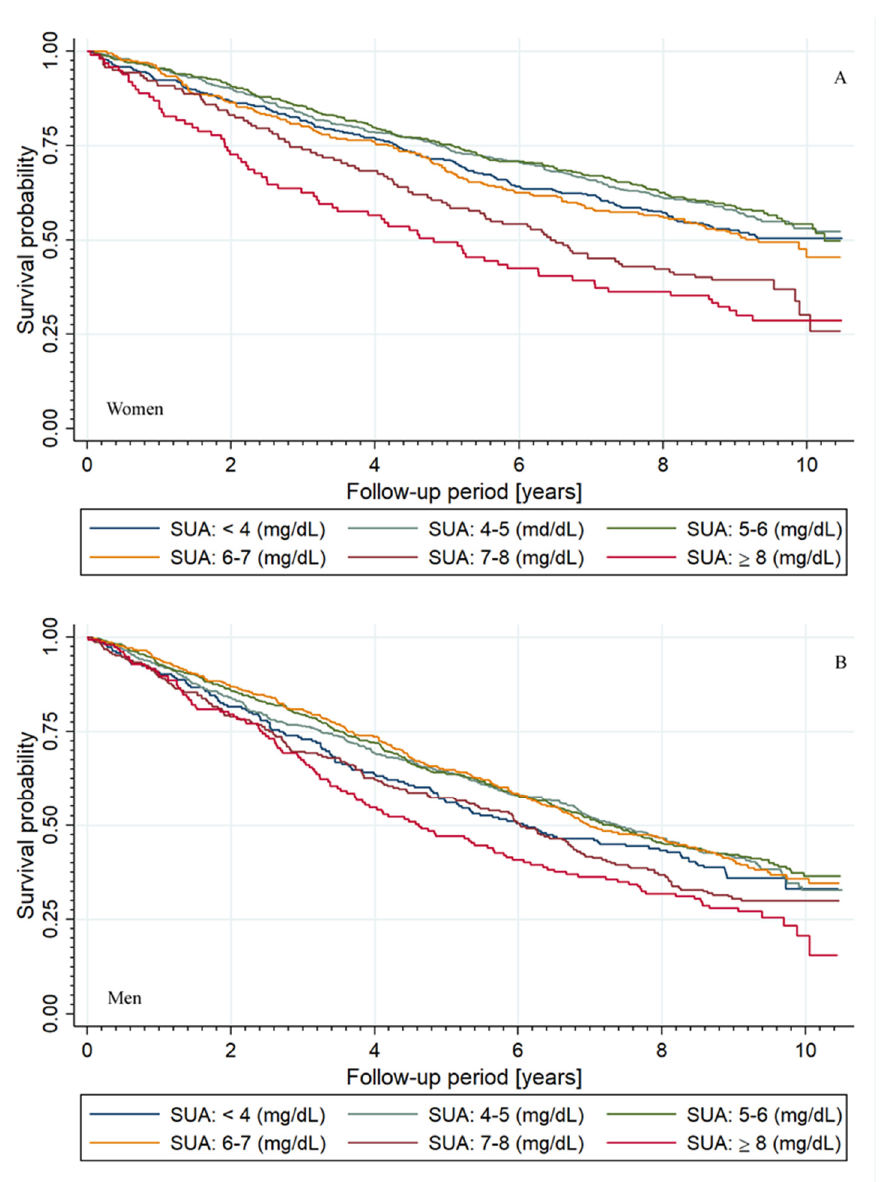
Figure 2. Kaplan–Meier survival estimates according to the SUA level subgroups. In comparison to the lowest cohort, groups with SUA ≥ 7 have increased overall mortality over time ( p < 0.01). ( A ) Survival estimates for women; ( B ) survival estimates for men.